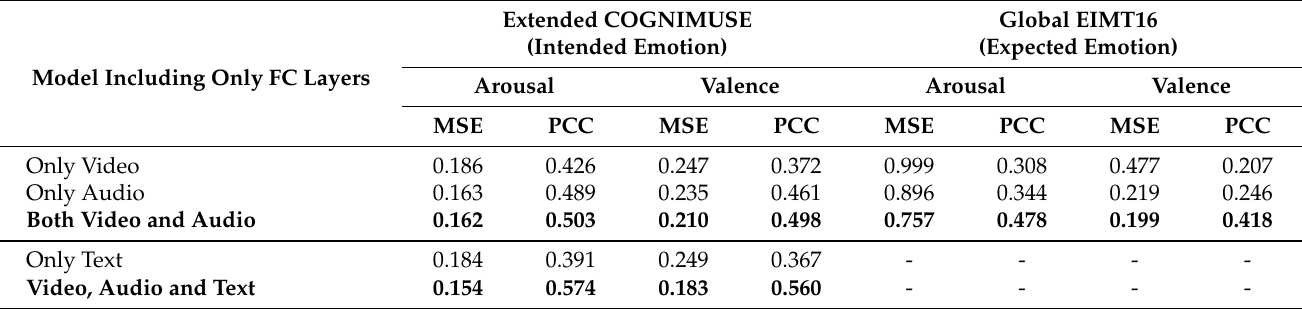
Table 6. Predicting arousal and valence directly (without using Malandrakis’ approach): model including only fully connected (FC) layers.